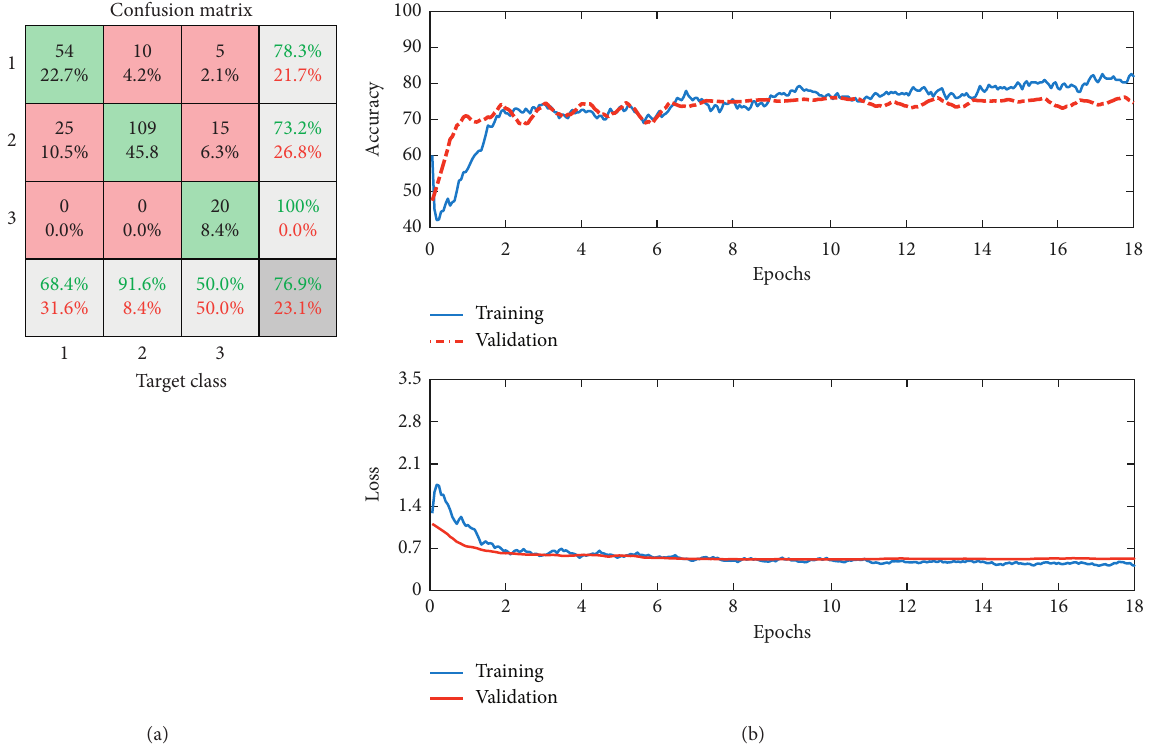
Figure 10: (a) Confusion matrix and (b) accuracy and loss curves for the combination of GWT and GoogLeNet.